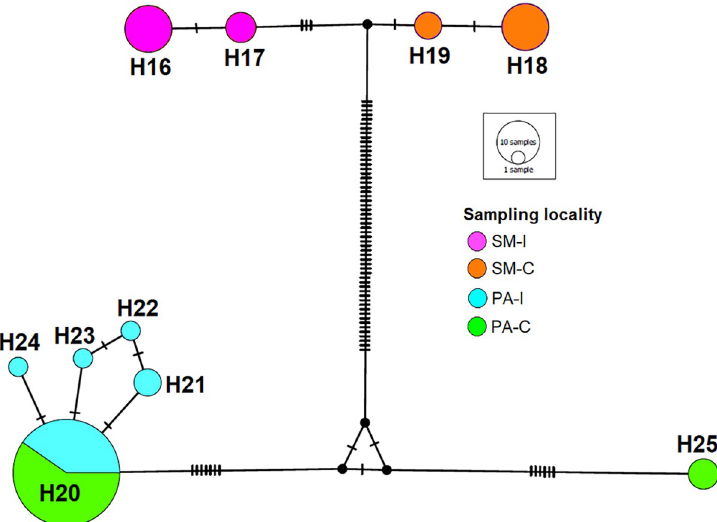
Fig 3. Phylogeographic network. Unrooted phylogeographic network using COI and cyt b gene sequences with haplotypes depicted according to colors and sampled localities in Fig 1. SM-I: Santa Marı´a Island, SM-C: Santa Marı´a